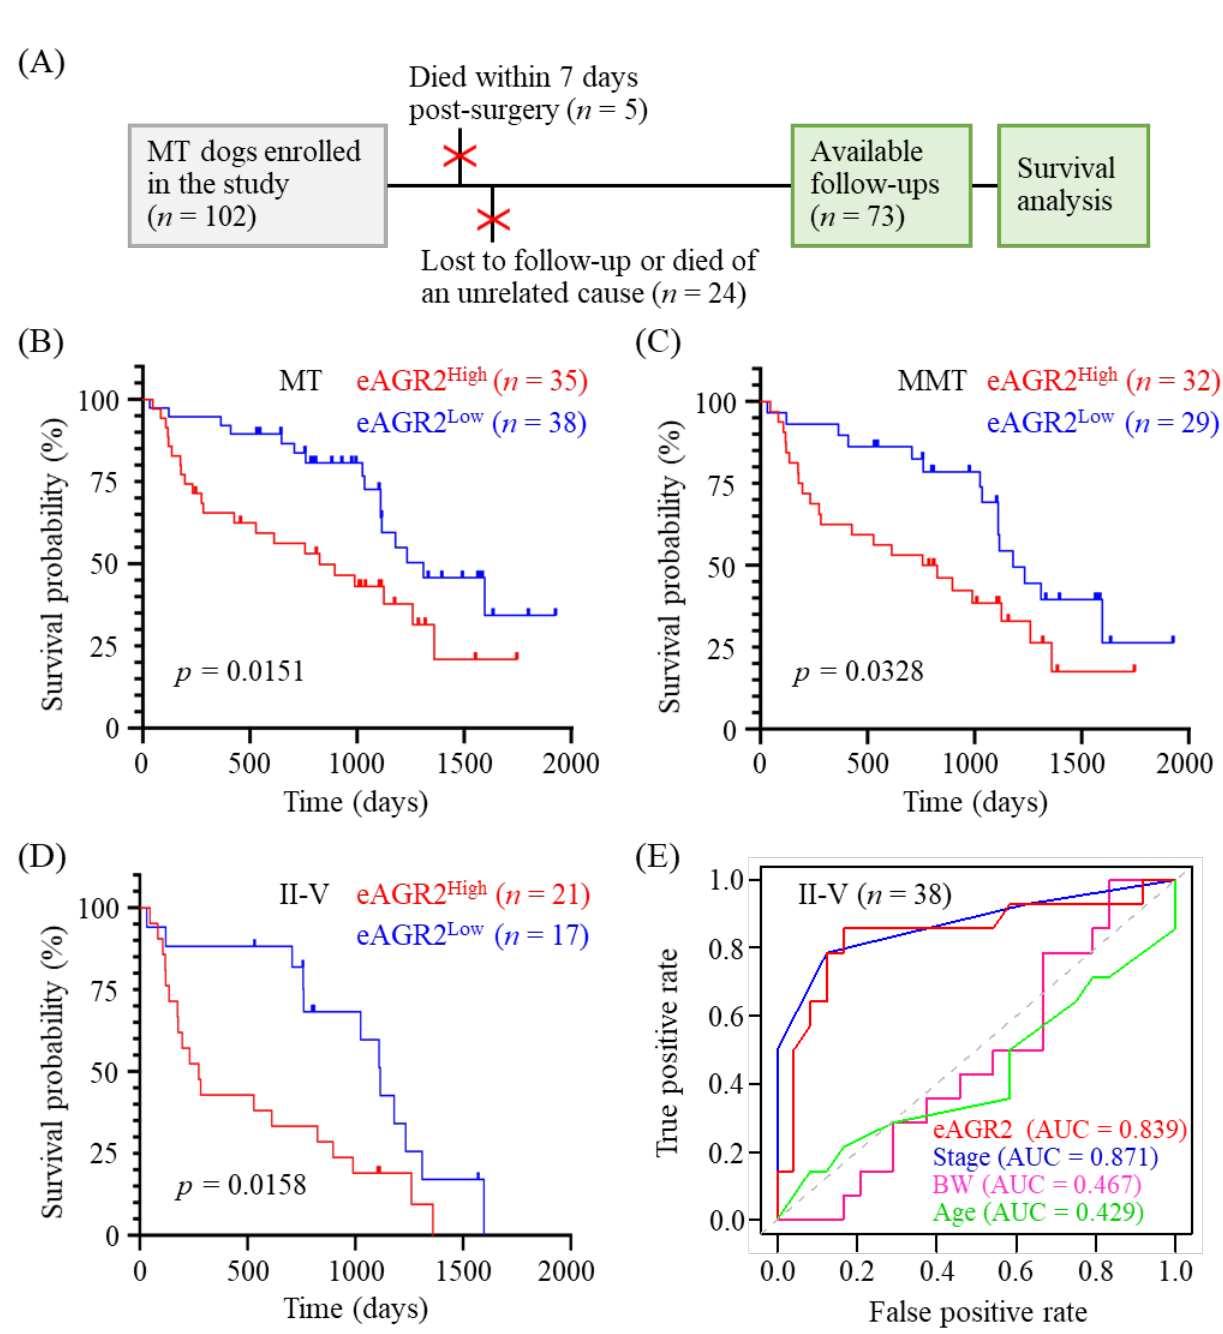
Figure 6. Correlation of serum eAGR2 concentration with adverse MMT prognosis. ( A ) Enrollment of 73 MT dogs with post-surgery follow-ups in the overall survival (OS) analysis. ( B , D ) Comparison of OS between MT dogs with low and high concentrations of serum eAGR2. Kaplan–Meier survival plots depict differences in survival probability between eAGR2 Low and eAGR2 High groups in ( B ) 73 MT cases, ( C ) 61 MMT cases, and ( D ) 38 MMT cases in stage II to V. Statistical significance was determined by the log-rank test. ( E ) Time-dependent receiver operating characteristic curve (ROC) of utilizing serum eAGR2 concentration or other clinicopathological factors for predicting OS of dogs with MMTs in stage II to V. Area under ROC (AUC) was calculated as indicated.